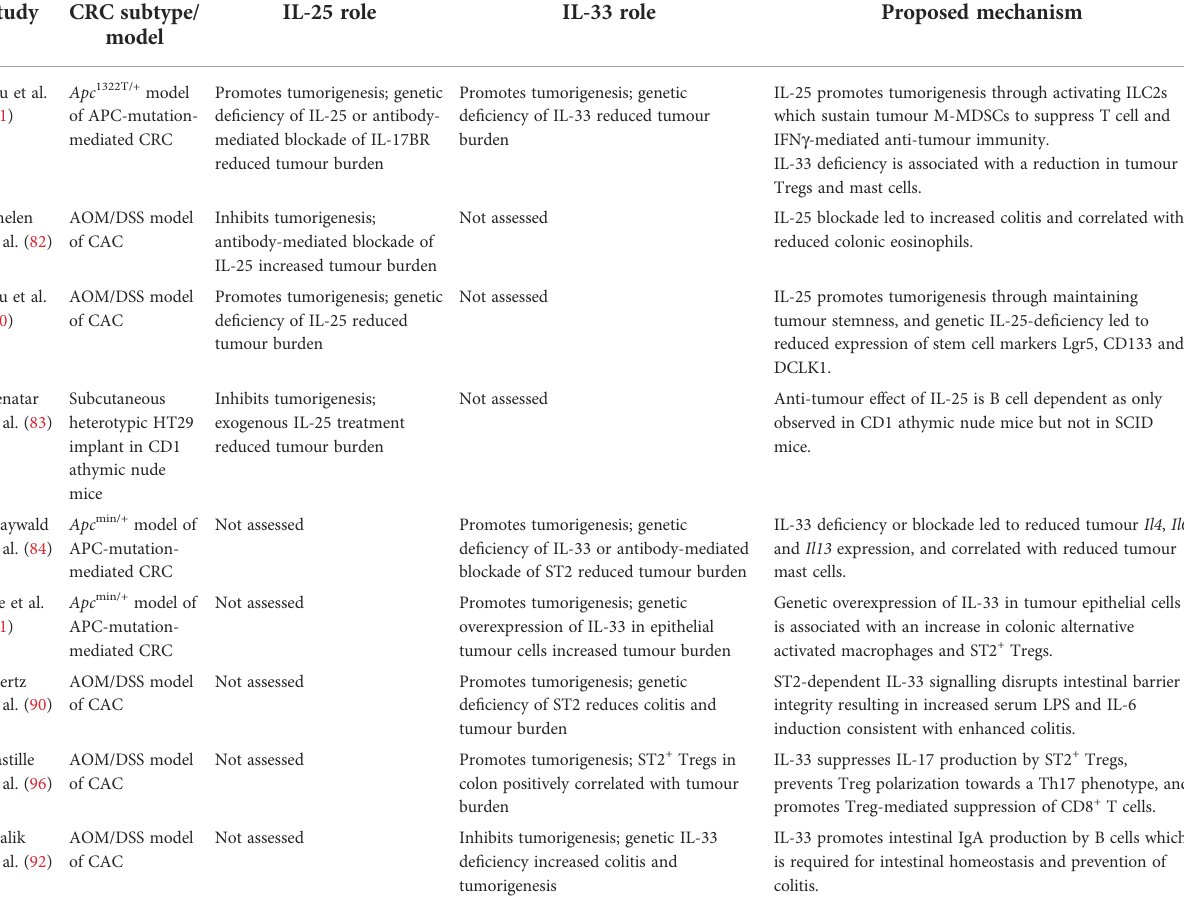
TABLE 1 Summary of animal studies illustrating the pro and anti-tumorigenic roles of IL-25 and IL-33 in different models of